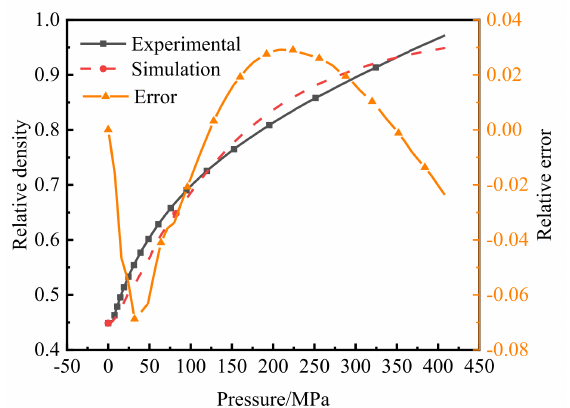
Figure 9. Comparisons of the compaction equation from numerical simulations and experimental results.